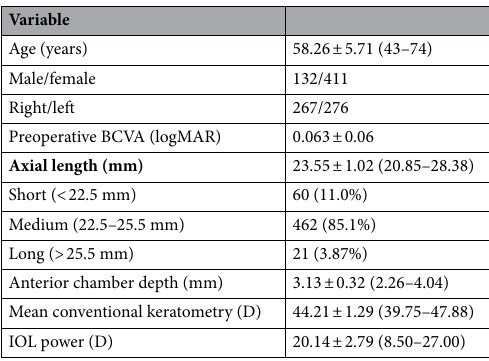
Table 1. Patients’ demographics and biometric measurements. BCVA best corrected visual acuity, D diopters, IOL intraocular lens.